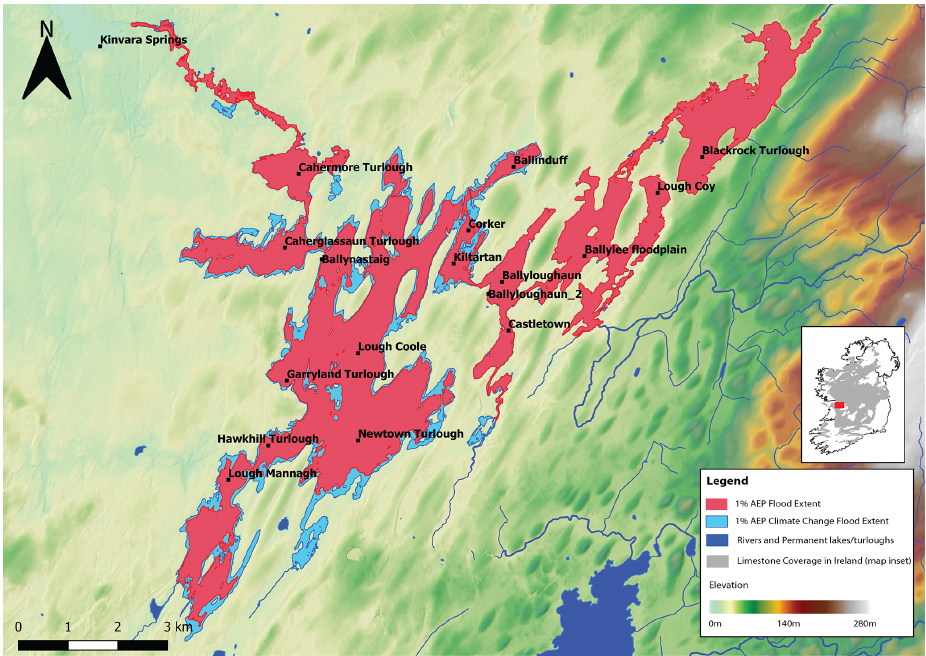
Figure 11. Comparison of the spatial extent of the 1% AEP flood event for the study catchment and the associated increases predicted during the RCP4.5 (medium) ensemble scenario. This figure contains Irish Public Sector Data (Geological Survey Ireland), licensed under a Creative Commons Attribution 4.0 International (CC-BY 4.0)